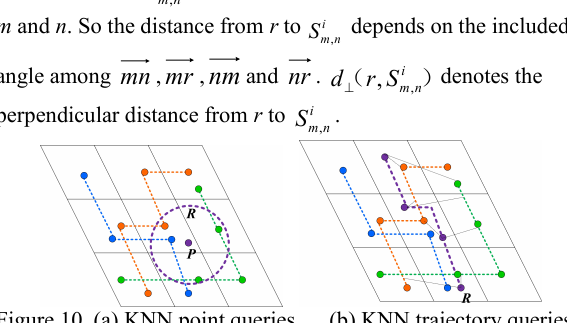
Figure 10. (a) KNN point queries (b) KNN trajectory